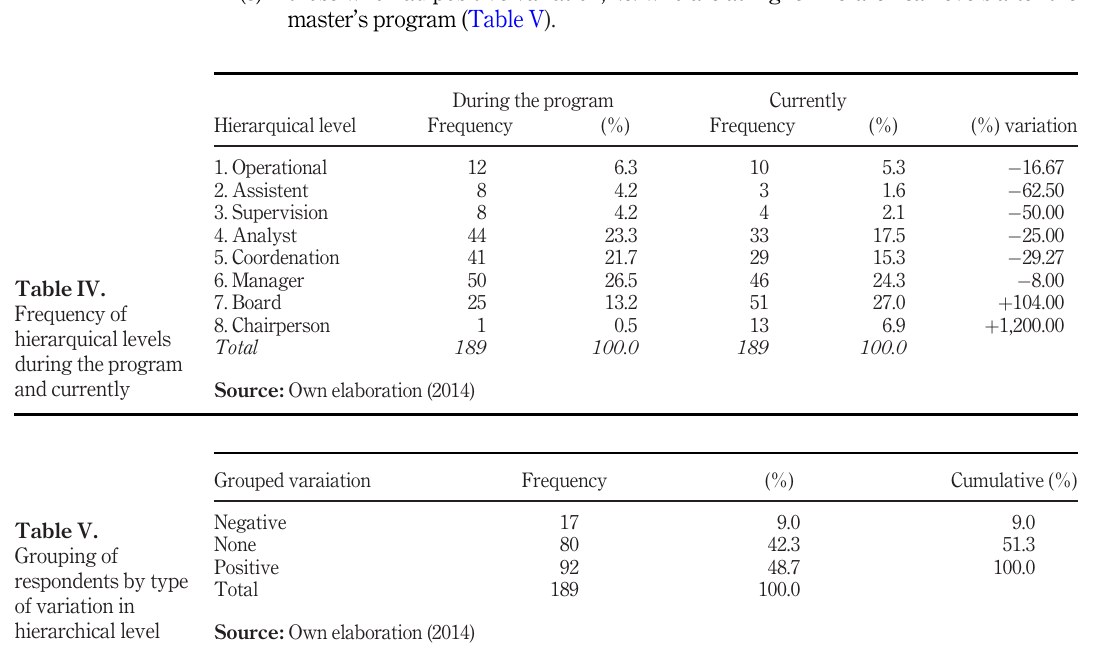
Hierarquical level